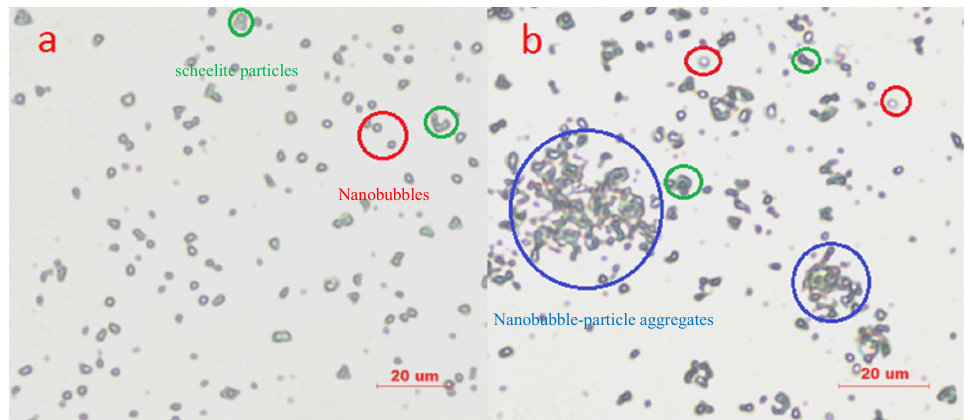
Figure 6. Interaction of particles and NBs under two cavitation treatments (( a ): HC pretreatments of reagent solution (HCPS); ( b ): HC pretreatments of pulp (HCPP); C(NaOl) = 2 × 10 −4 mol/L).